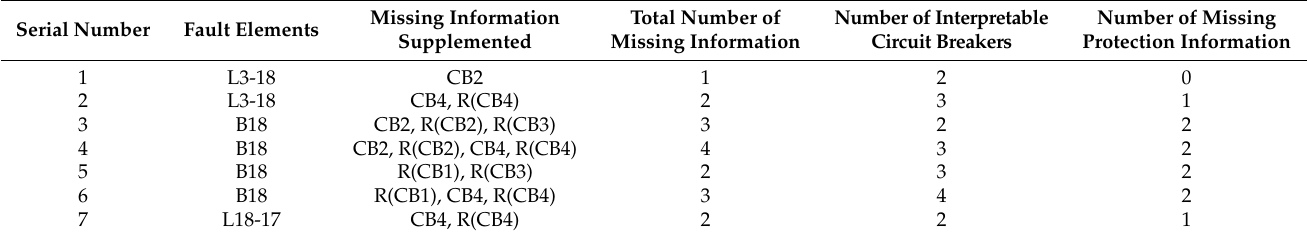
Table 3. The hypothesis of a single fault.